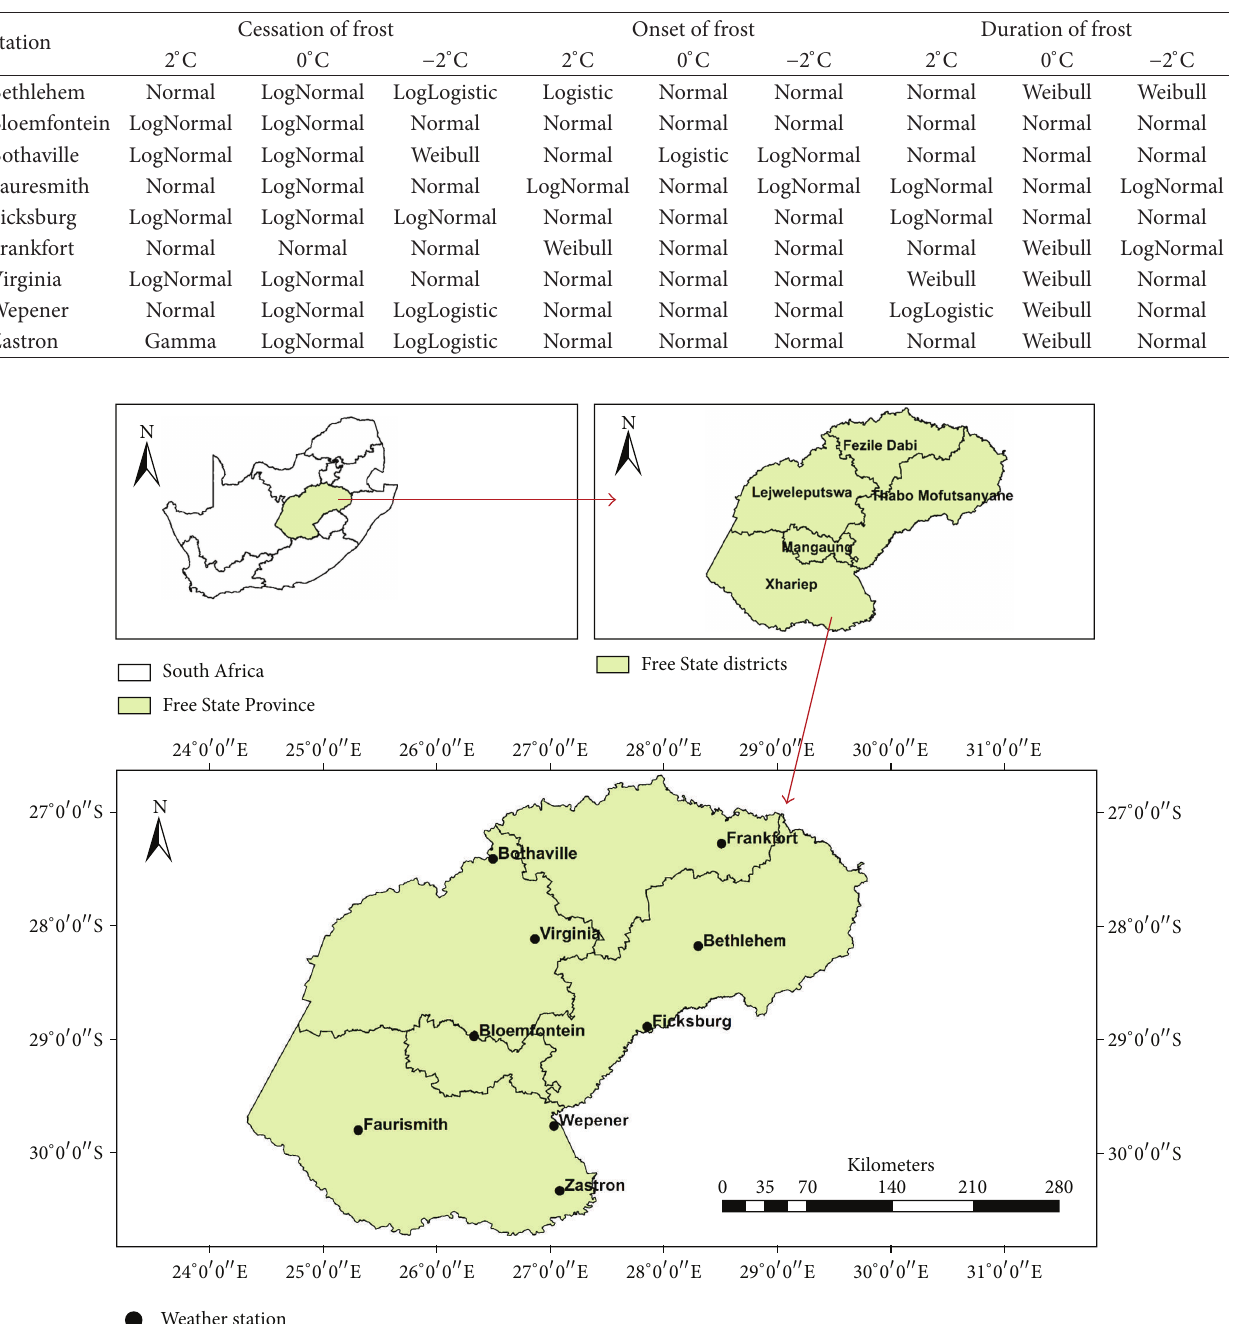
Table 2: Distribution fitting of frost indices at different thresholds (2 ∘ C, 0 ∘ C, and − 2 ∘ C).